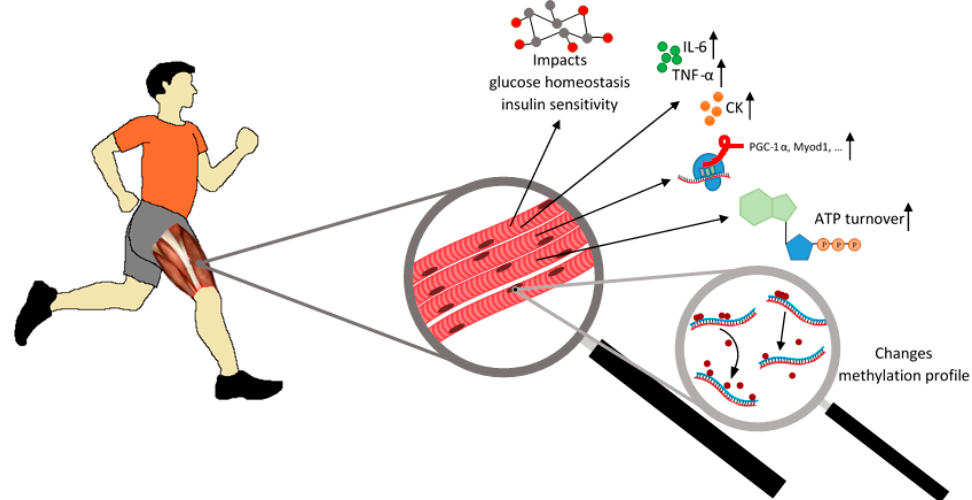
Figure 1. Exercise affects the metabolism of muscle cells. Exercise impacts glucose homeostasis and insulin sensitivity, enhances the release of creatine kinase (CK), and pro-inflammatory cytokines such as interleukin-6 (IL-6) and tumor necrosis factor α (TNF- α ) as well as increases ATP turnover. Physical activity also induces changes in DNA methylation patterns and influences the expression of many genes in muscle tissue.